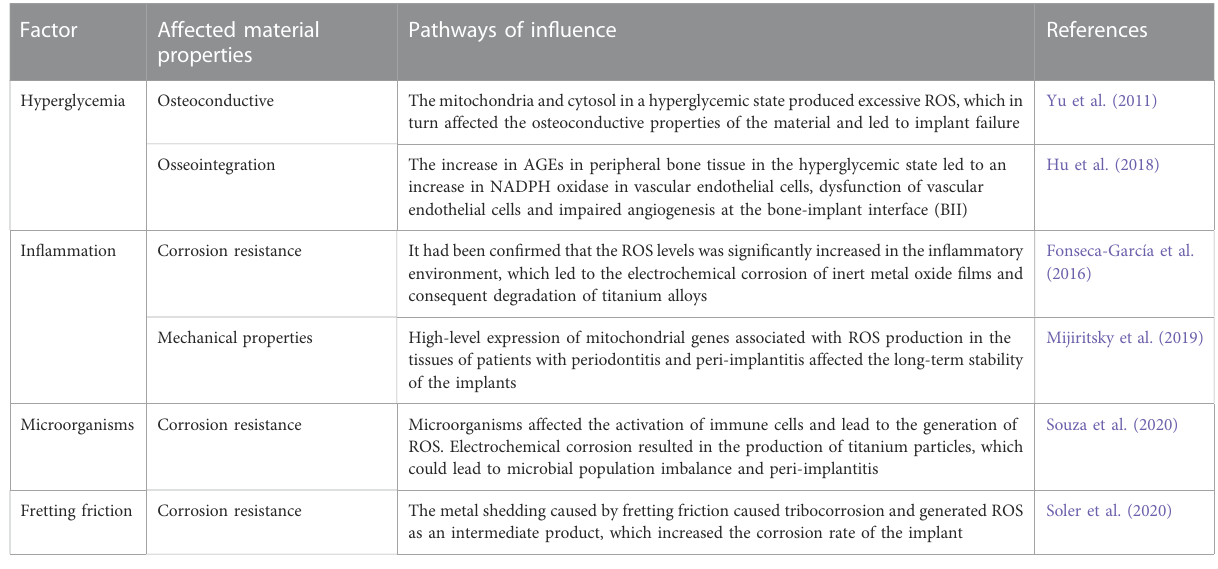
TABLE 2 Material properties affected by oxidative